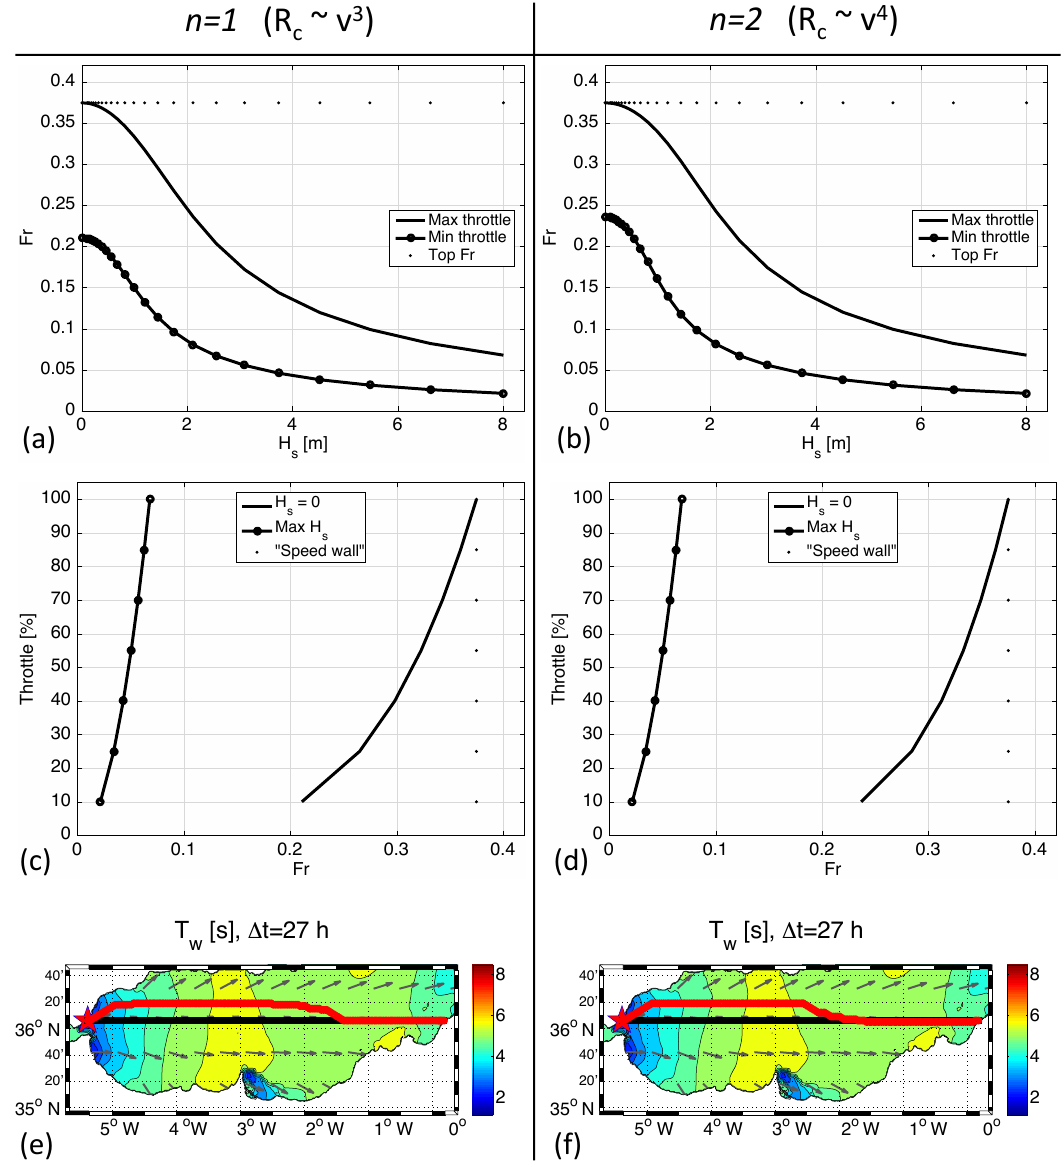
Figure 16. Comparison of the effect of different parametrizations of C T drag coefficient, depending on q exponent in Eq. (B1). (a, b) Froude number Fr at a constant engine throttle vs. significant wave height (cf. Fig. 4b). (c, d) : Engine throttle needed for sustaining a given Fr (cf. Fig. 5b). (e, f) The final time step of the routes in case study #3 (cf. Fig.